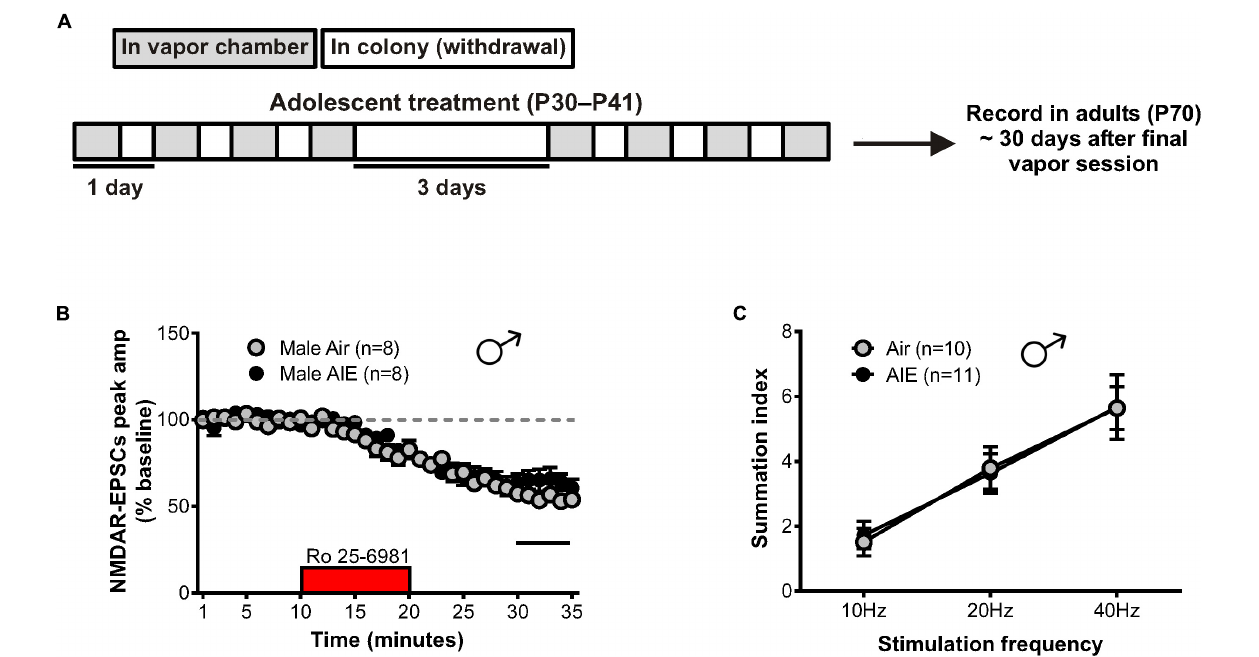
FIGURE 5 | GluN2B transmission and NMDAR metaplasticity in adult male mice with a history of AIE. (A) Schedule showing the time course used to evaluate the duration of the plastic changes observed in the male adolescent BNST following chronic intermittent ethanol. Recordings were obtained 30 days after the final vapor chamber session ( ∼ P70). (B) Time course of NMDAR-EPSC peak amplitudes in Air- and AIE-treated male adults following a 10-min application of Ro 25–6981. In contrast to the enhancement of GluN2B-mediated transmission observed in adolescent males exposed to chronic intermittent ethanol, there was a trend toward a significant reduction of GluN2B in adults with a history of AIE (unpaired t -test comparing group differences of the percentage change in EPSC amplitude from 5 min before Ro addition to the last 5 min of washout [black line]). (C) Plot of the summation index across stimulation frequencies and treatments demonstrating no significant difference in adult males with a history of AIE relative to controls. All data points indicate mean ±